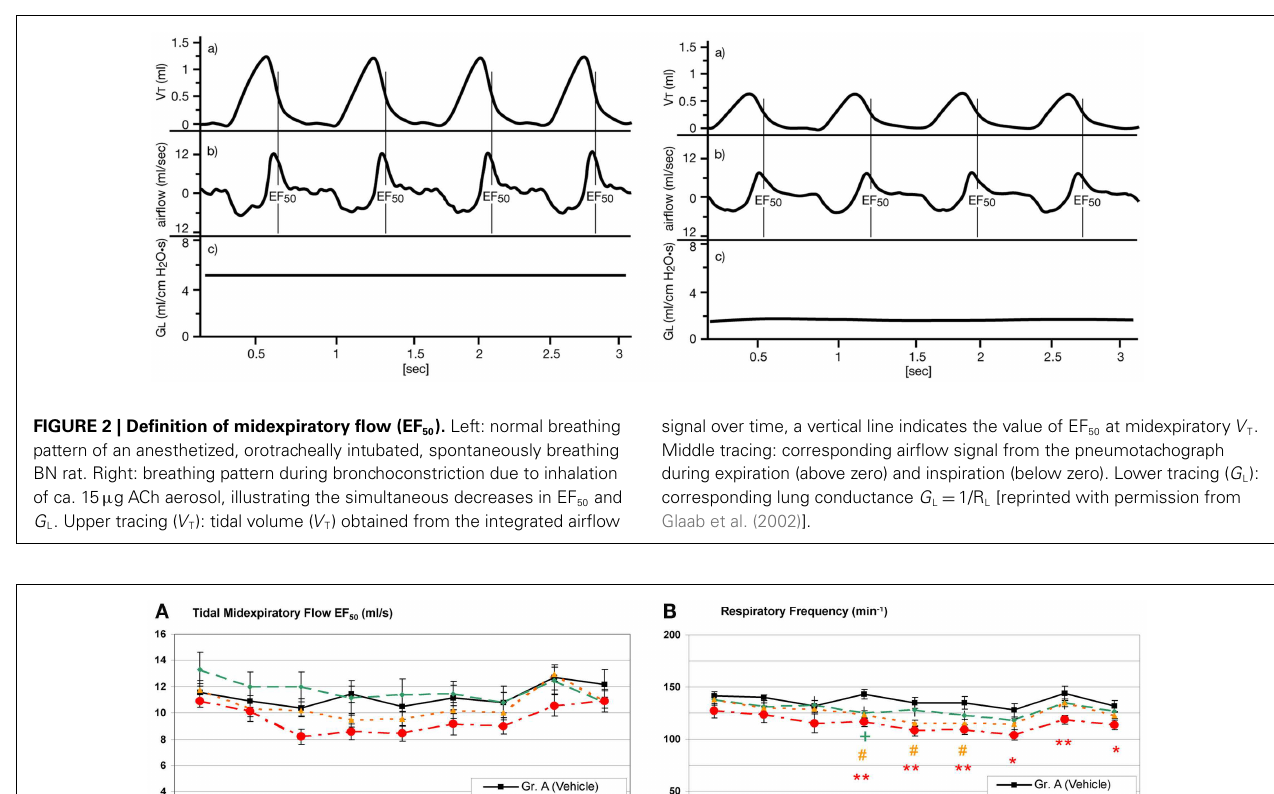
FIGURE 3 | Head-out plethysmography in a safety pharmacology core battery study: (A) Tidal midexpiratory flow (EF 50 ) and (B) respiratory frequency measured after a single intragastric treatment with a